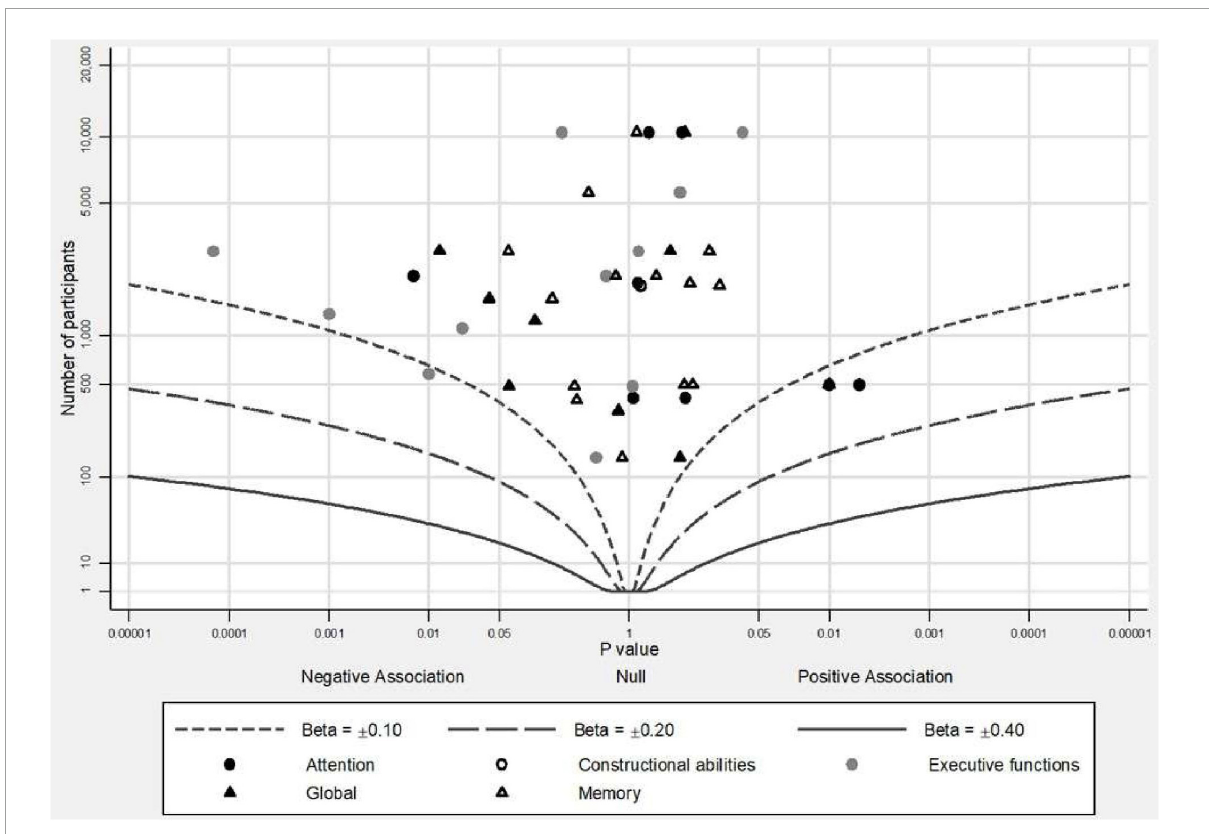
FIGURE3 Albatross plot of studies that investigated the association of MetS with continuous outcomes of